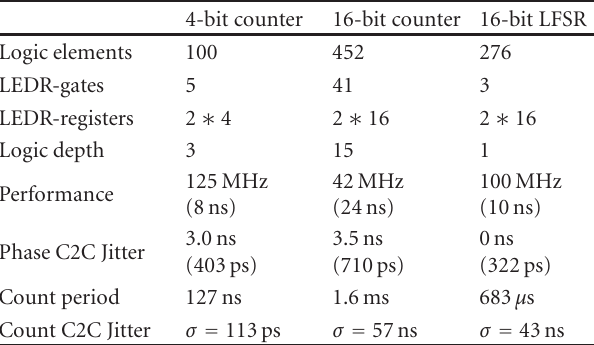
Table 1: Example circuits